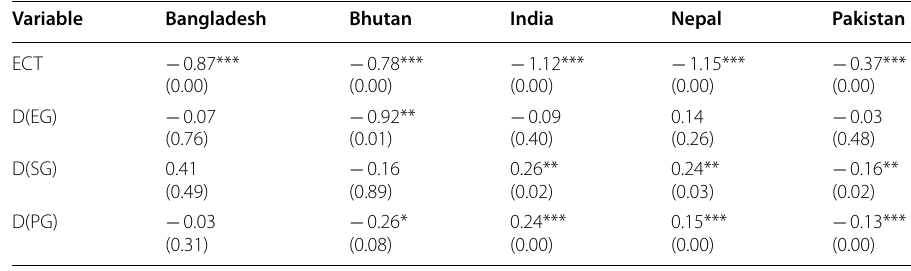
*, **, and *** indicate statistical significance at the 10%, 5%, and 1% levels, respectively. Dependent variable: Real GDP Growth ( Y ); Independent variable: EG Economic Globalization Index, SG Social Globalization Index, and PG Political Globalization Index of KOF. P values of the corresponding statistics in Panel B are in parentheses